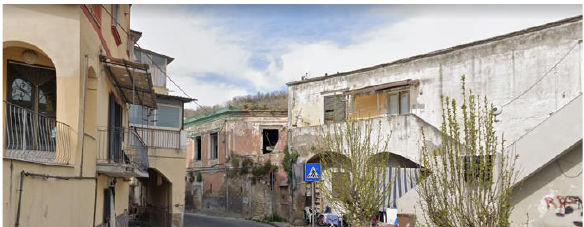
Figure 3. Farmhouses in the urban texture of